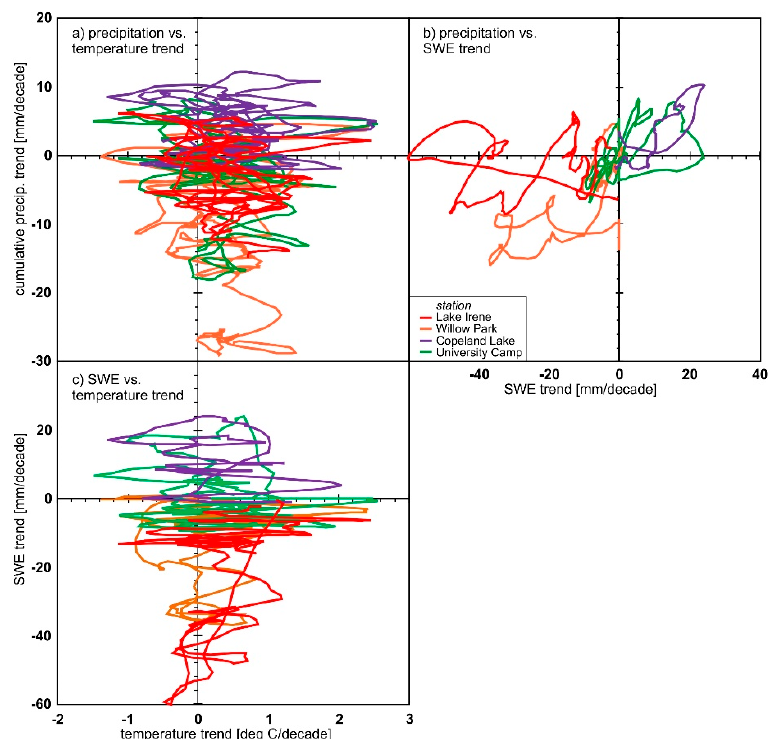
Figure 9. Comparison of the 7-day running average ( a ) cumulative precipitation trend versus temperature trend, ( b ) cumulative precipitation trend versus SWE trend, and ( c ) SWE trend versus temperature trend for three sample stations.